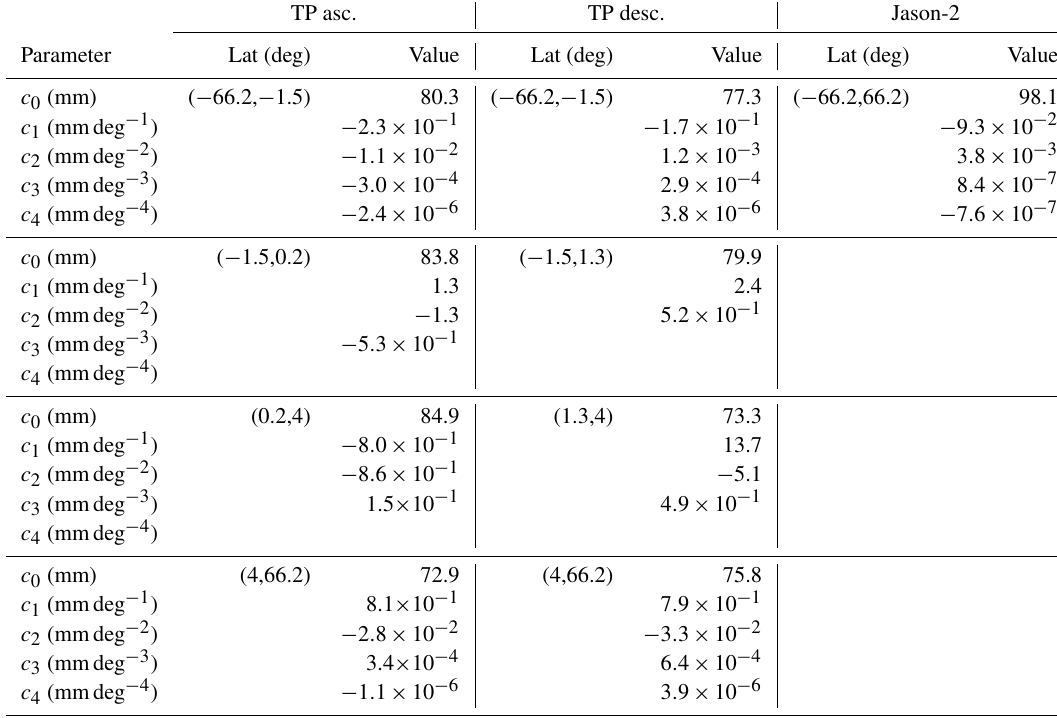
Table A1. Values for the parameters of the latitudinal intermission bias correction. These numbers are added to the sea surface height anomalies of the respective satellites. “TP asc.” and “TP desc.” indicate the function variables that should be added to the ascending and descending tracks, respectively, of TOPEX/POSEIDON using Eq. (4). J2 indicates the function variables to be used for Jason-2. TP